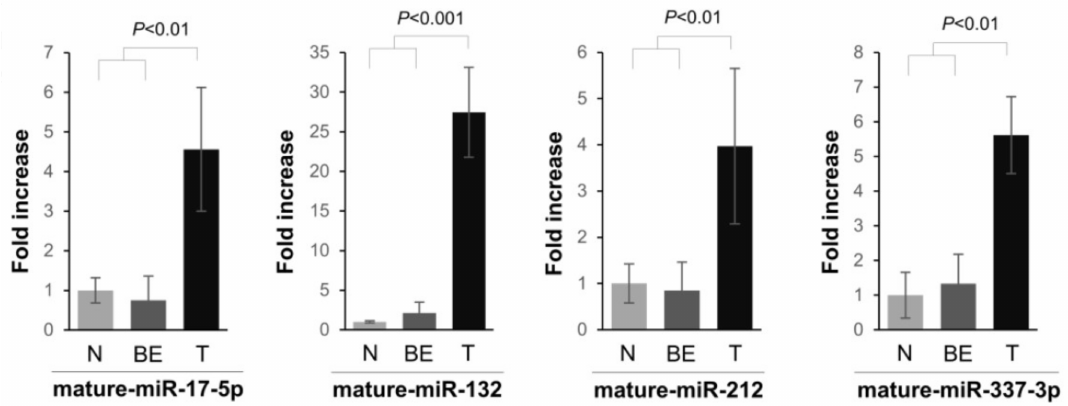
Figure 1. Expression levels of mature miRNAs, miR-17-5p, miR-132-3p, miR-212-3p, and miR-337-3p in normal (N), benign (BE), and malignant (T) human pancreatic tissues. The expression of miRNAs was quantified using the TaqMan MicroRNA Assay. miRNA expression was related to the 18S ribosomal RNA internal control, and data were calculated using the comparative C T method. The relative fold increase of miRNAs with respect to normal tissues are